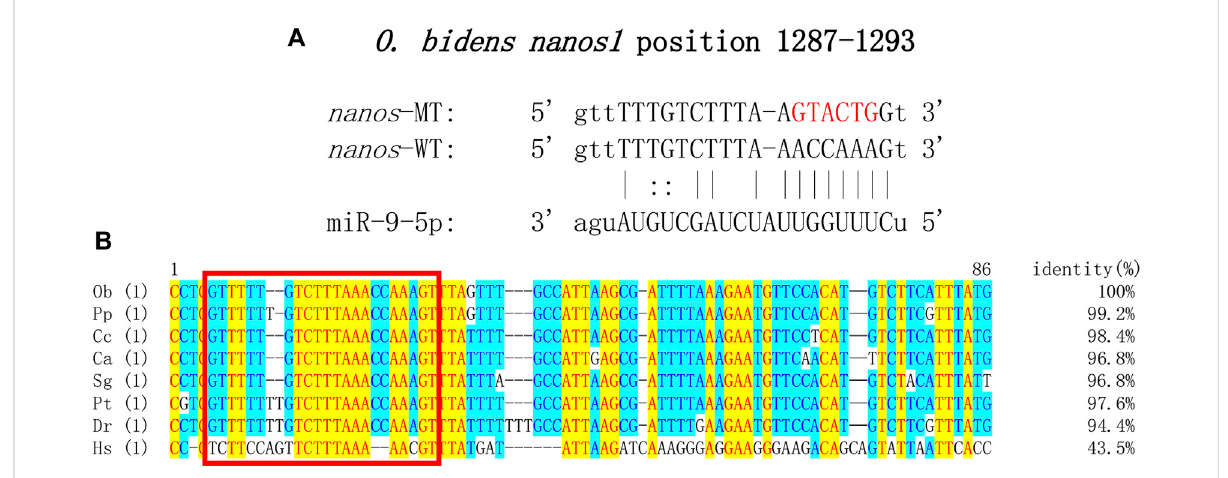
FIGURE 6 Target sequence veri fi cation. (A) Target site prediction of miR-9-5p and nanos1 (position: 1287 – 1293). Red represents the randomly mutated bases. (B) Sequences of binding site of nanos1 and alignment. The abbreviation for species is as follows: Ob, Opsariichthys bidens ; Pp, Pimephales promelas ; Cc, Cyprinus carpio ; Ca, Carassius auratus ; Sg, Sinocyclocheilus graham ; Pt, Puntigrus tetrazona ; Dr, Danio rerio ; Hs, Homo sapiens . Red square: binding site of miR-9-5p to nanos1 .